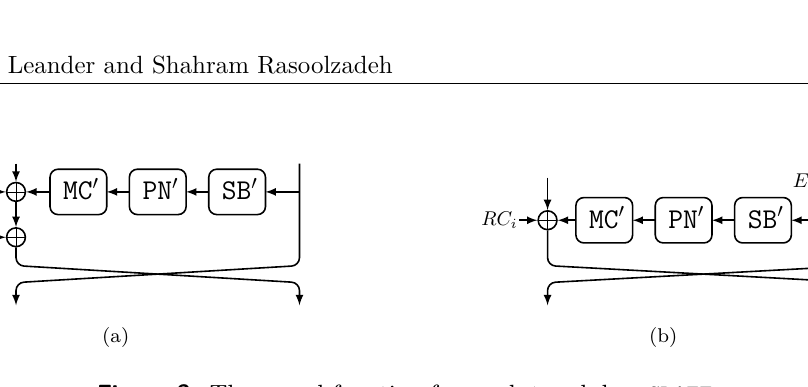
Figure 3: The round function for weak tweak-key CRAFT